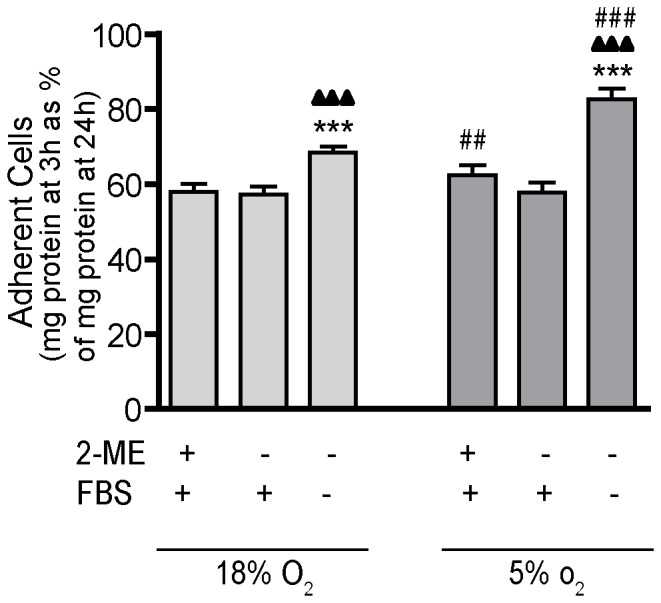
Influence of O2 tension, 2-ME and serum on the rate of THP-1 differentiation.Differentiation of THP-1 cells from monocytic to macrophage cells is associated with transition from a non-adherent to an adherent cell type. To determine whether culture conditions affect PMA-stimulated differentiation of THP-1 cells to macrophages, cell adhesion was assessed at 3 and 24 h after addition of PMA (20 ng/ml) to the culture medium. Data are presented as the mean ± SEM of the protein concentration of adherent cells at 3 h as a percentage of the protein concentration of adherent cells at 24 h (n = 4 independent experiments). *Significantly different from +2-ME+FBS (standard culture conditions) under the same oxygen tension (one-way ANOVA and post hoc Tukey’s test); ▴Significantly different from –2-ME+FBS under the same oxygen tension (one-way ANOVA and post hoc Tukey’s test); #Significantly different from the same culture condition in the 18% O2 group (e.g., 18% O2
versus 5% O2) by Student’s t-test. **, ##, ▴▴
p<0.01; ***, ###, ▴▴▴
p<0.001.